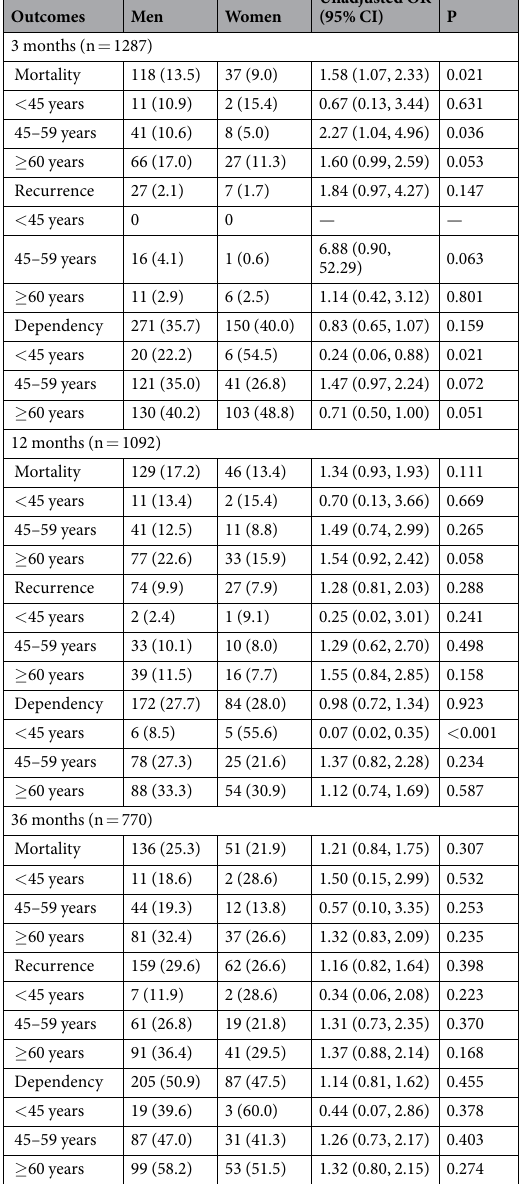
Table 2. Sex differences in outcomes at 3, 12, 36 months after